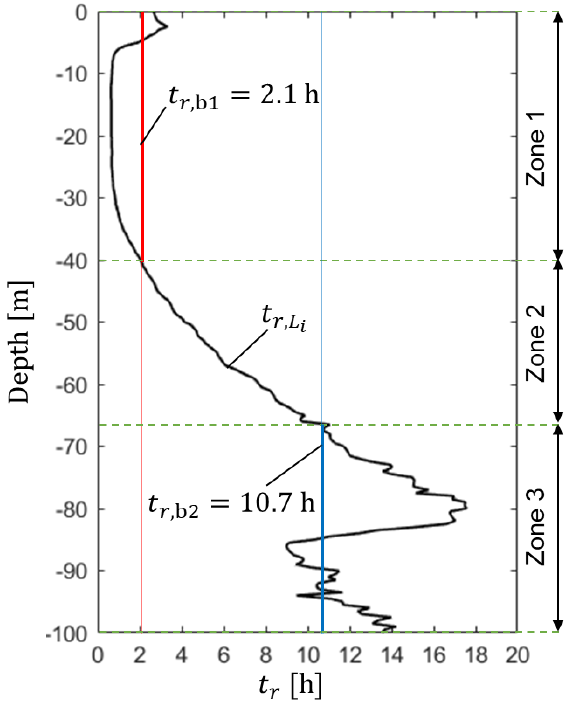
Figure 7. RTT according to the groundwater velocity.